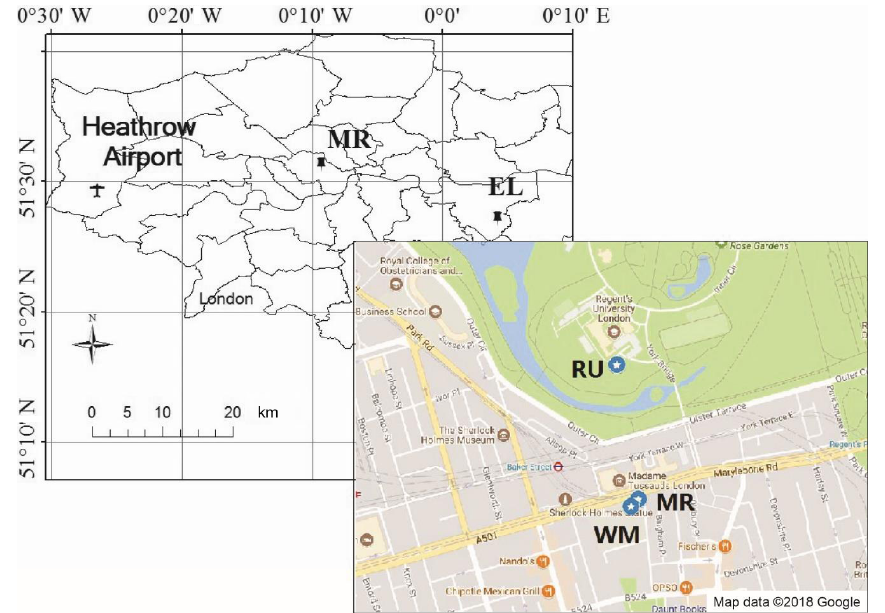
Figure 1. Map of the sampling sites. RU – Regents University (15m above ground); WM – University of Westminster (20m above ground); EL – Eltham; MR – Marylebone Road (south